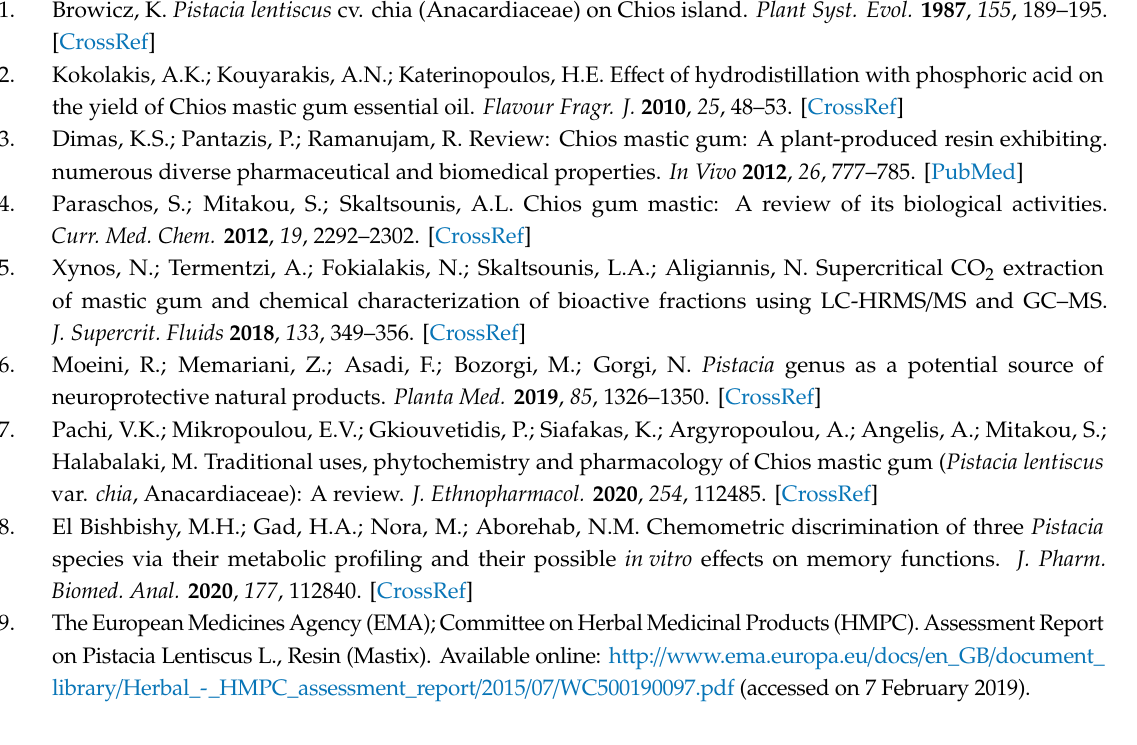
Figure S4. (A) PANC-1, untreated, (B) PANC-1, 50 µ g / mL MGEO-1, (C) PANC-1, 50 µ g / mL MGEO-2, (D) PANC1, 50 µ g / mL MGEO-3, (E) PC3, untreated, (F) PC3, 50 µ g / mL MGEO-1, (G) PC3, 50 µ g / mL MGEO-2, (H) PC3, 50 µ g / mL MGEO-3, (I) A549, untreated, (J) A549, 50 µ g / mL MGEO-1, (K) A549, 50 µ g / mL MGEO-2, (L) A549, 50 µ g / mL MGEO-3. Figure S5. (A) RAW 264.7, untreated, (B) RAW 264.7, 50 µ g / mL MGEO-1, (C) RAW 264.7, 50 µ g / mL MGEO-2, (D) RAW 264.7, 50 µ g / mL MGEO-1, (E) SK-MEL-30 untreated, (F) SK-MEL-30, 50 µ g / mL